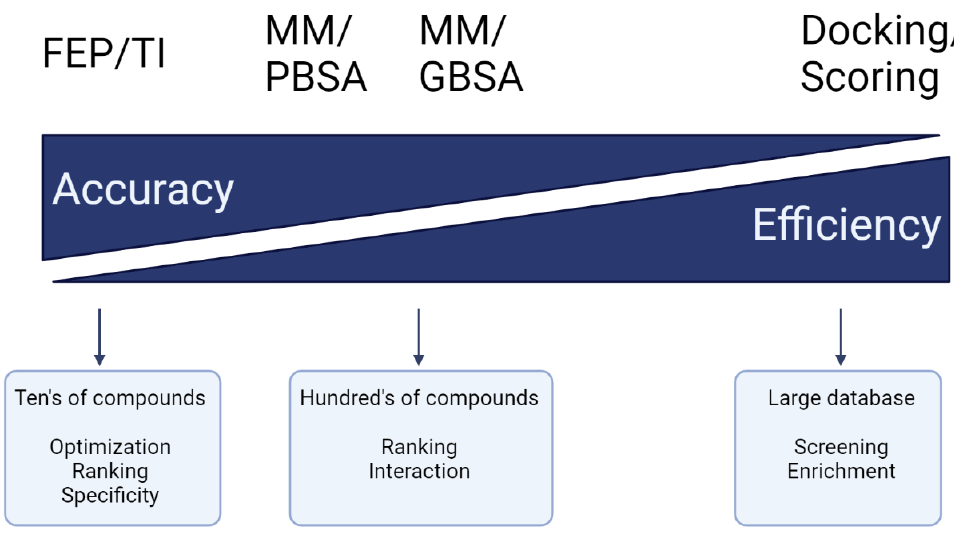
Figure 14. The distribution of the regular free energy calculation methods in accuracy/efficiency scale and their applications in drug discovery.